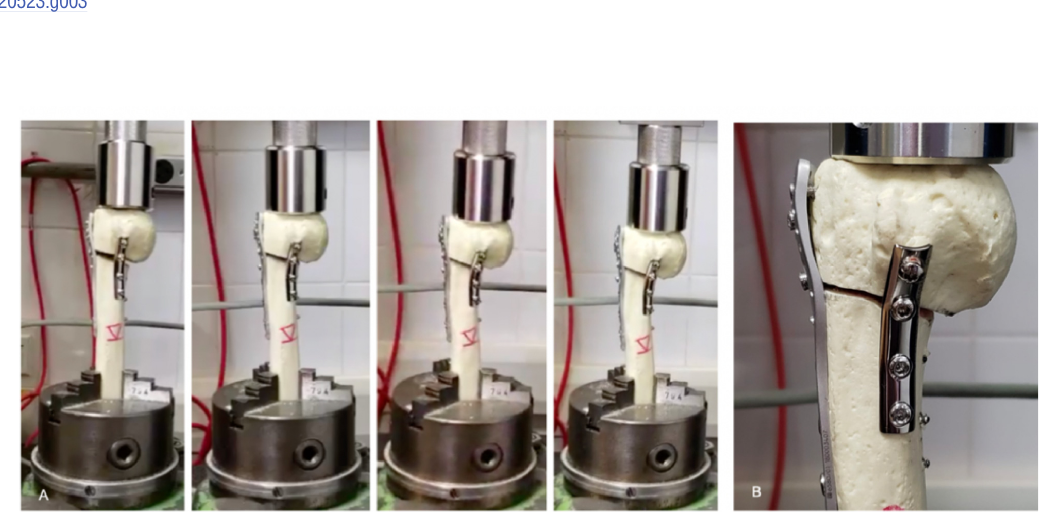
Fig 4. Sequence of mechanical testing in one model of Group L+T. A. Four phases identified during the test. Note that gradually humerus head suffered substantial varus collapse and both medial and lateral gap disappear; B. Mode of failure of Group L+T: there were obvious loosening of the proximal part of the lateral locking plate from the humerus head due to varus displacement. In addition, the two most proximal screws from the anteromedial nonlocking plate pushed out from the humerus head as well. There were no signs of breakage of any screws or plates nor hardware cut-out or cut-through.